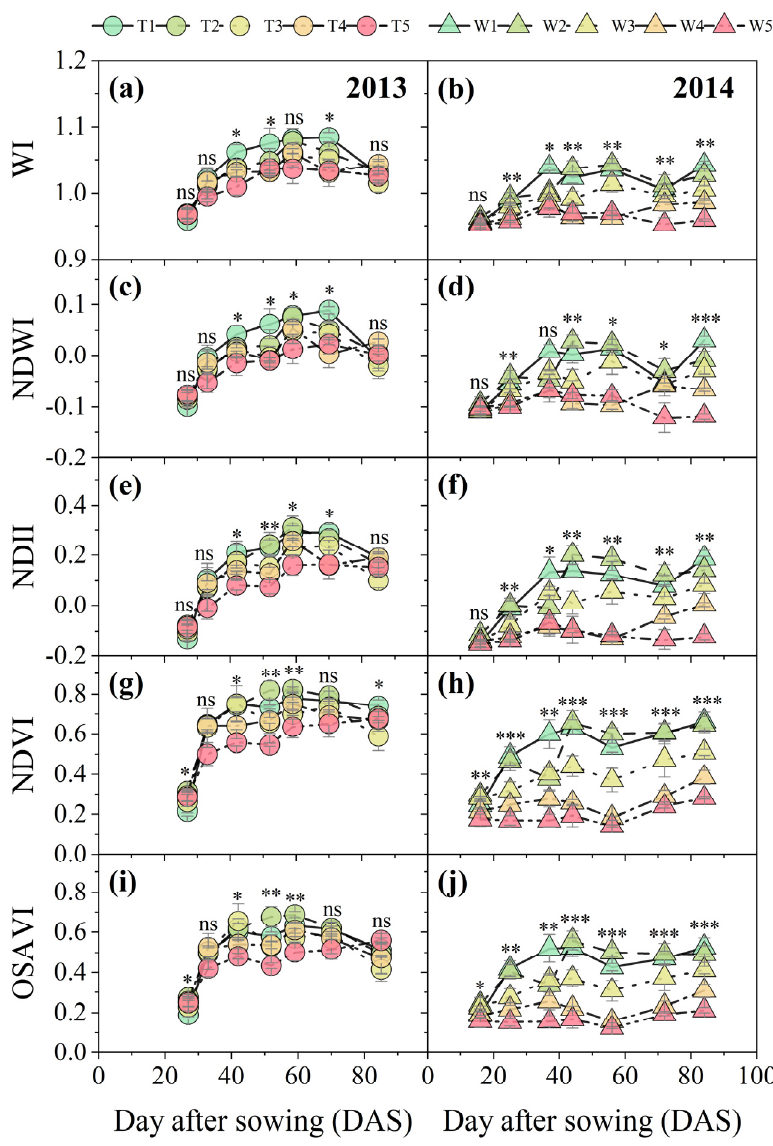
Figure 4. Temporal variability in vegetation indices (WI, NDWI, NDII, NDVI, and OSAVI) during soil drying among different irrigation treatments in the 2013 ( a , c , e , g , i ) and 2014 ( b , d , f , h , j ) growing seasons. WI, water index; NDWI, normalized difference water index; NDII, normalized difference infrared index; NDVI, normalized difference vegetation index; and OSAVI, optimal soil-adjusted vegetation index. The “***”, “**”, and “*” denote significant differences among treatments based on the analysis of variance (ANOVA) at p < 0.001, p < 0.01, and p < 0.05 levels, respectively, while “ns” indicates no significant differences. Error bars denote mean ± SE.